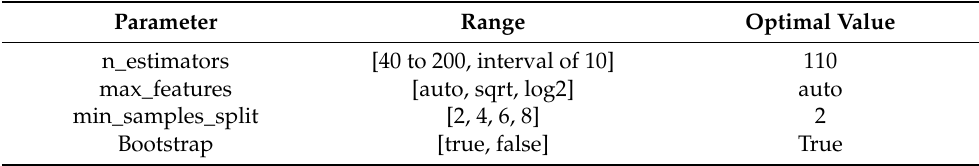
Table A3. Hyperparameter tuned for the random forest classifier.